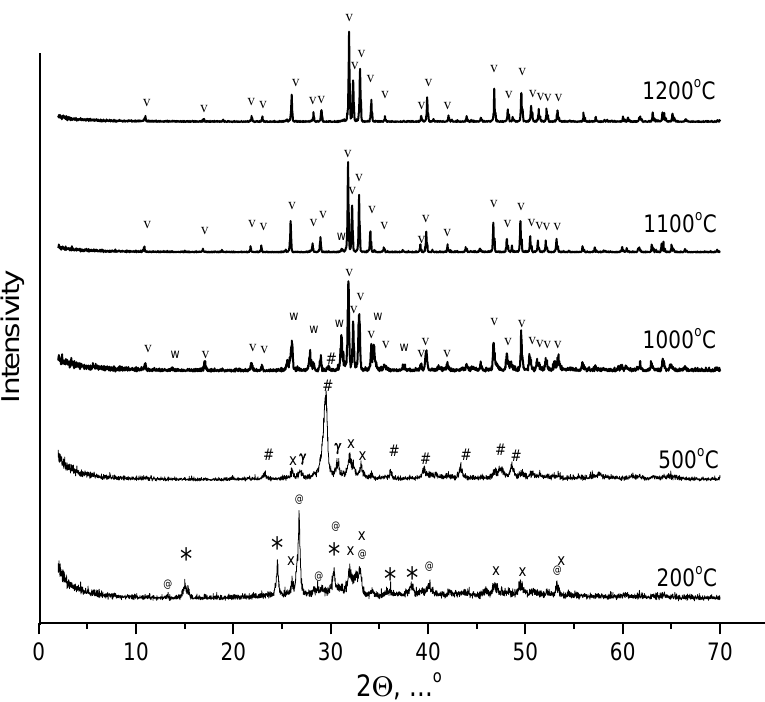
Figure 5. XRD data for powder mixture (200 ◦ C) and ceramic samples (500 ◦ C, 1000 ◦ C, 1100 ◦ C and 1200 ◦ C) after firing: v—Ca 10 (PO 4 ) 6 (OH) 2 (PDF card 9-432); w— β -Ca 3 (PO 4 ) 2 (PDF card 9-169); “ # ”—